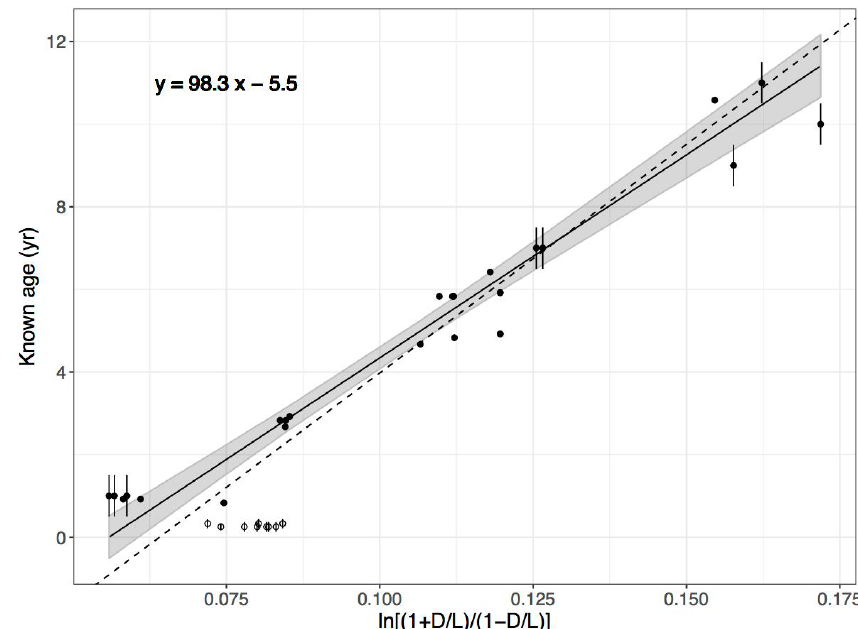
Fig. 1. Weighted linear regression of against known age (yr) for 26 pygmy goats. The dark band is the 95% confidence intervals for the line. The lines through each point are 2 times the standard deviation. Some points have practically no uncertainty and therefore very short lines. The dashed line is the estimation using the entire pygmy goat data set ( n = 35), and the open circles are the measurements from the youngest goats ( n = 9) that do not enter in the final